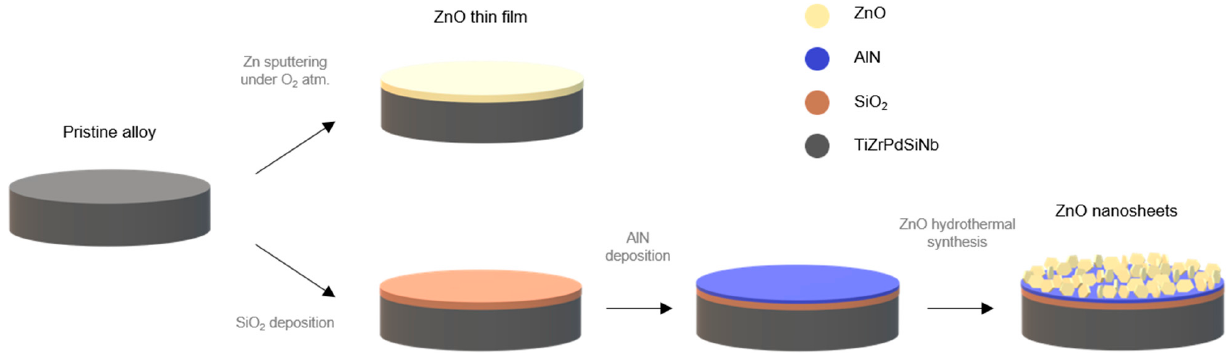
Figure 1. Schematic illustration of the coating process to obtain ZnO thin films (sputtering) and ZnO nanosheets (hydrothermal synthesis) on TiZrPdSiNb alloy.